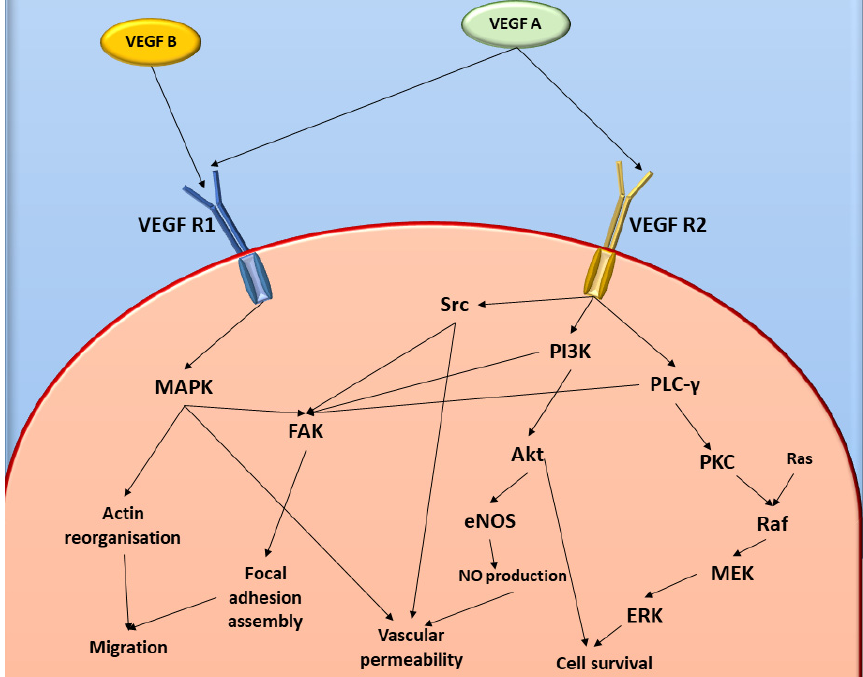
Figure 1. Diagrammatic representation of VEGF and FAK cell signalling pathways. Image was designed by DA Gomes using Microsoft ® Office PowerPoint (Microsoft Office enterprise 2007, 2006 Microsoft Corporation, Redmond, WA, USA).